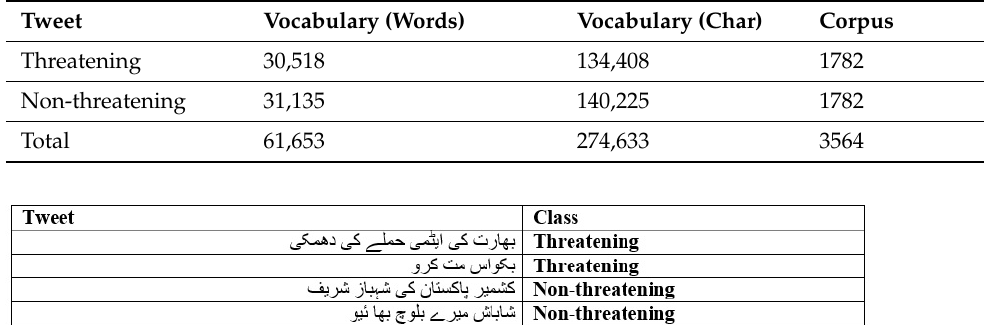
Figure 1. Workflow of the adopted methodology. Table 2. summary stats of dataset.